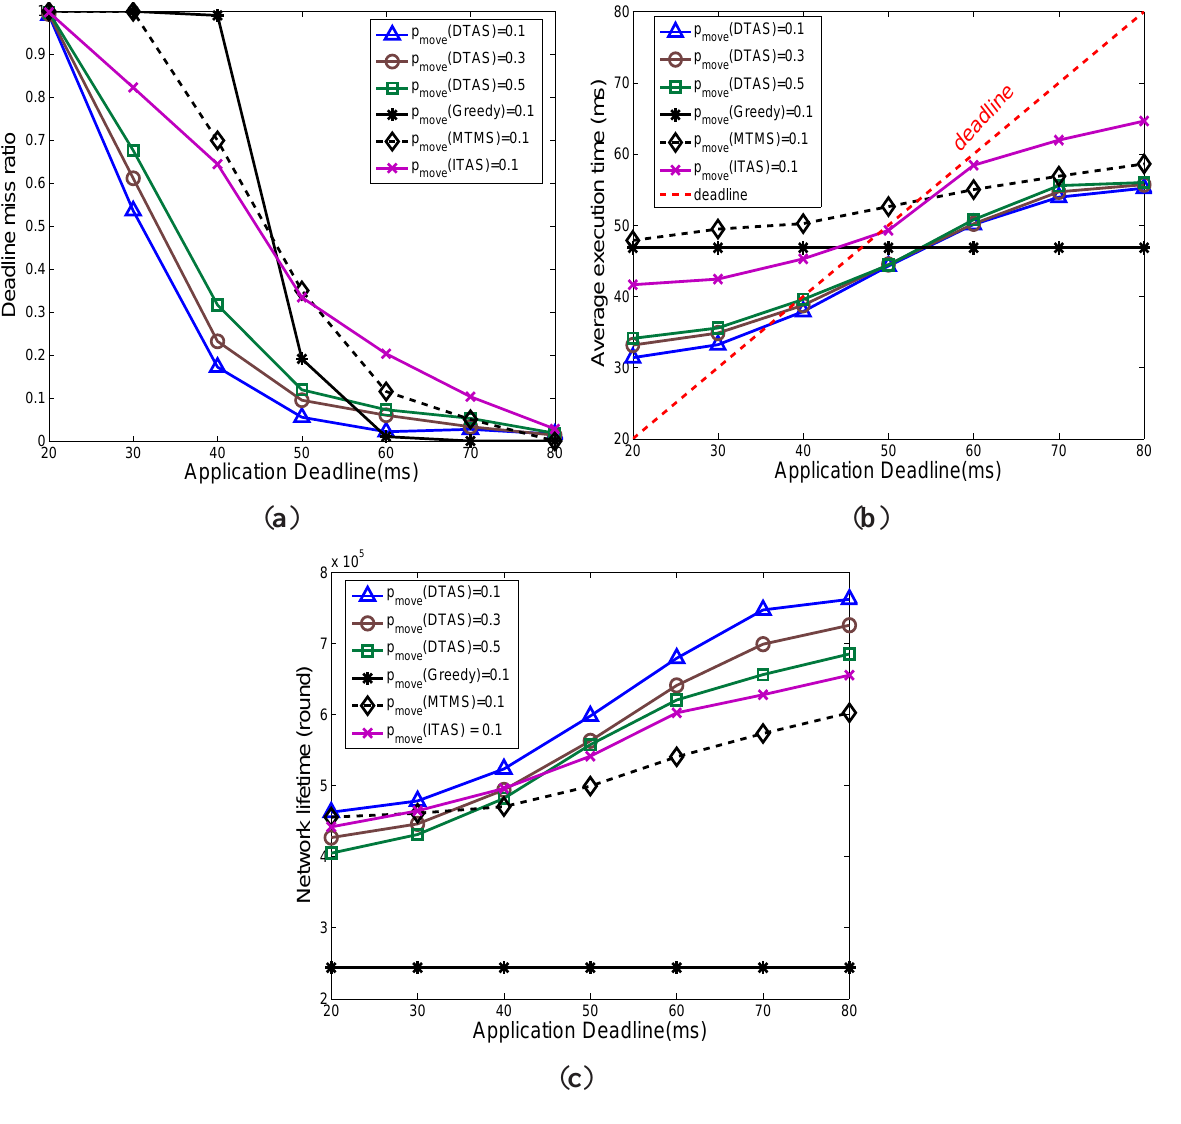
Figure 11. Effect of altering the deadline constraint. ( a ) Deadline miss ratio; ( b ) Average schedule length (SL); ( c ) Average Network lifetime